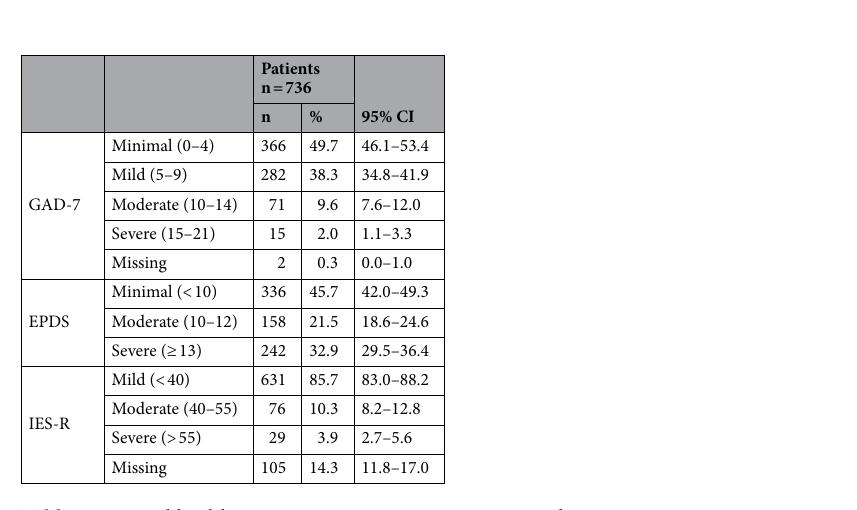
Table 2. Mental health assessment using GAD-7, EPDS and IES-R among